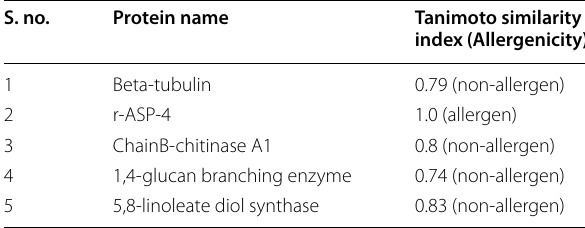
Table 2 Allergenicity of core proteins of A. fumigatus